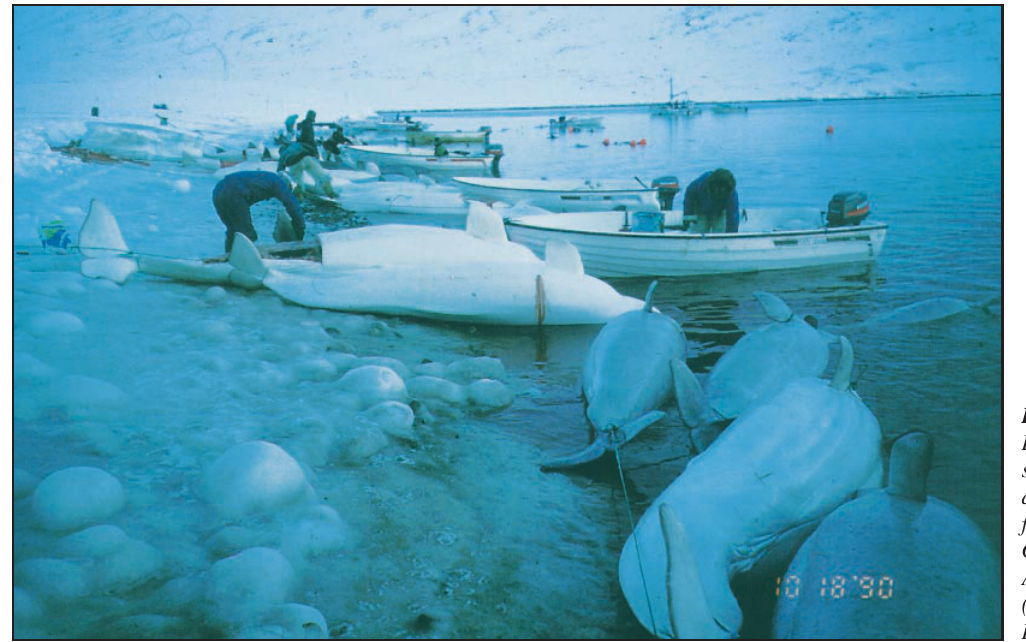
Fig. 1 Beluga meat, skin and blubber are important foods for people in Greenland and - Arctic Canada. (Photo: M.P.